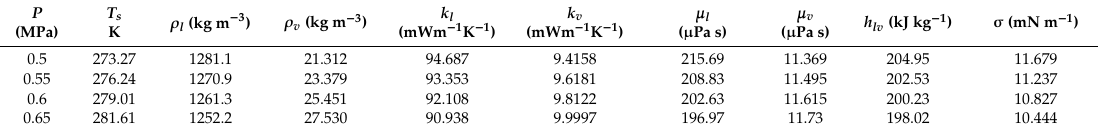
Table 2. Thermo-physical properties of the R22 under di ff erent